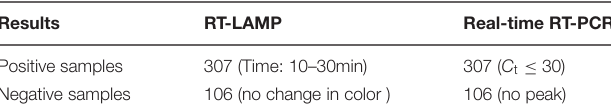
TABLE 2 | Reverse transcription loop-mediated isothermal amplification (RT-LAMP) and real-time reverse transcription-polymerase chain reaction (RT-PCR) findings of clinical blood or swab